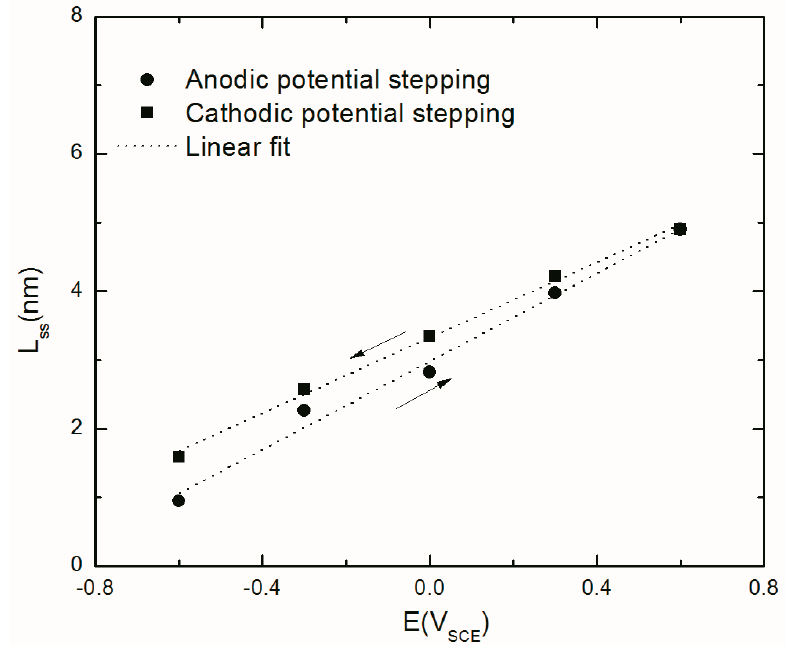
Figure 12. The steady-state thickness of the passive layer formed on AA2098 – T851 alloy in 0.1M